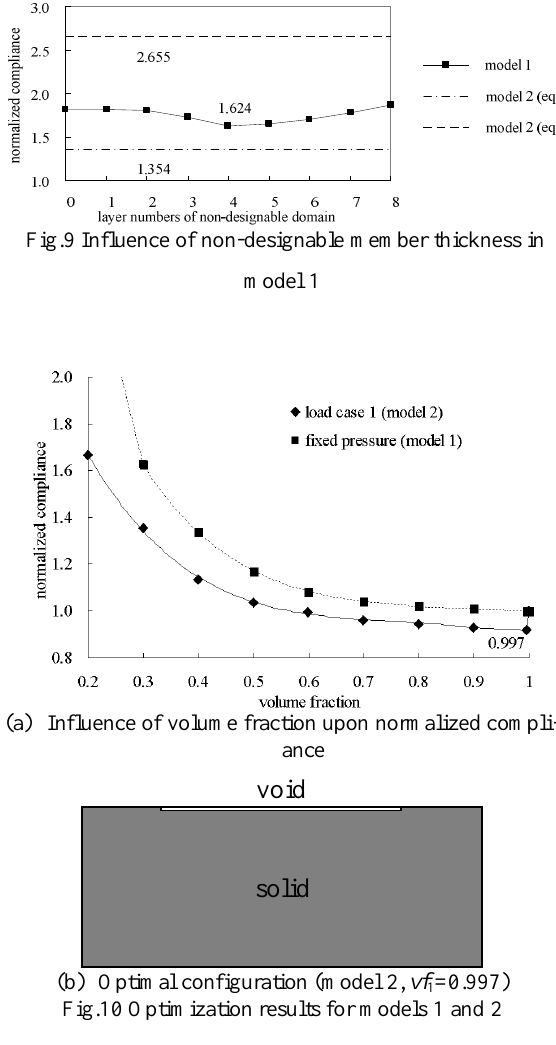
Fig.10 Optimization results for models 1 and 2